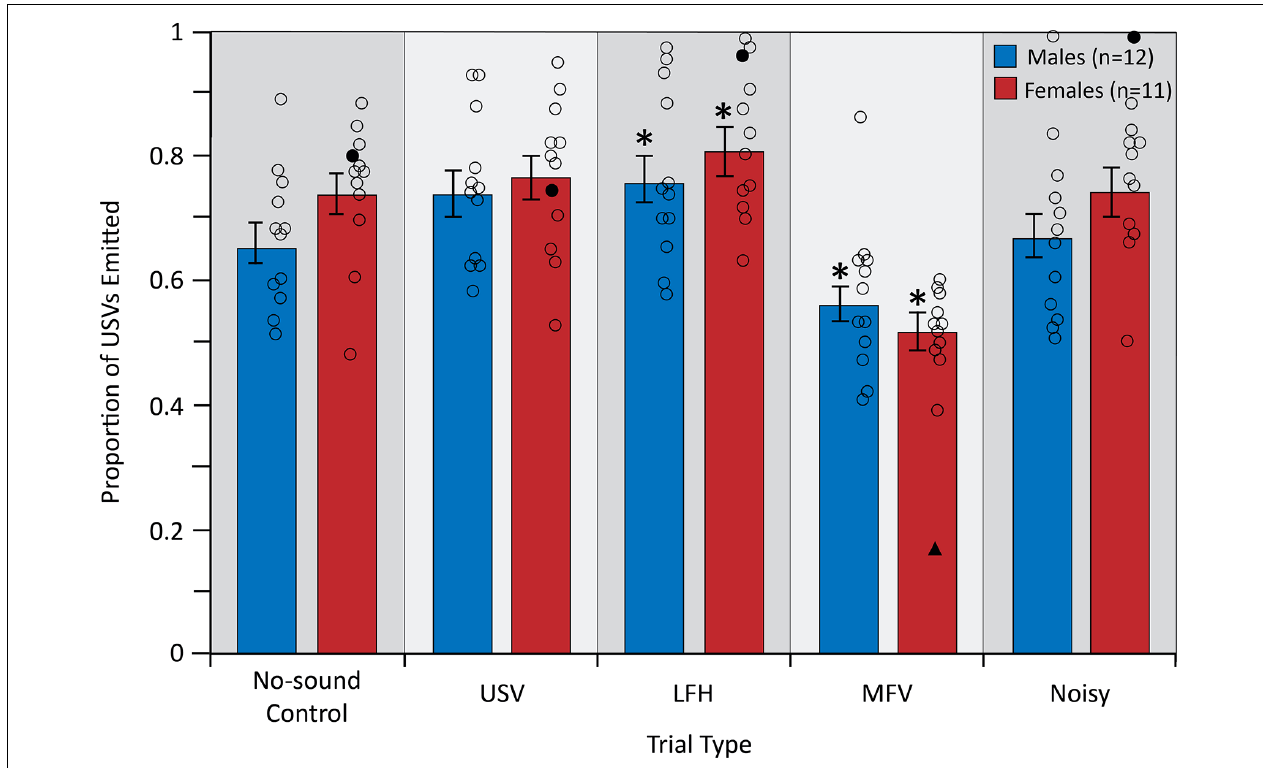
FIGURE 7 | The proportion of emitted USVs changed in LFH and MFV playback trials. For symbols, see Figure 4 . Outlier data excluded from this analysis (filled triangles and circles) were not from the same animal as in Figures 4 or 5 . *Differs from no-sound control, p <